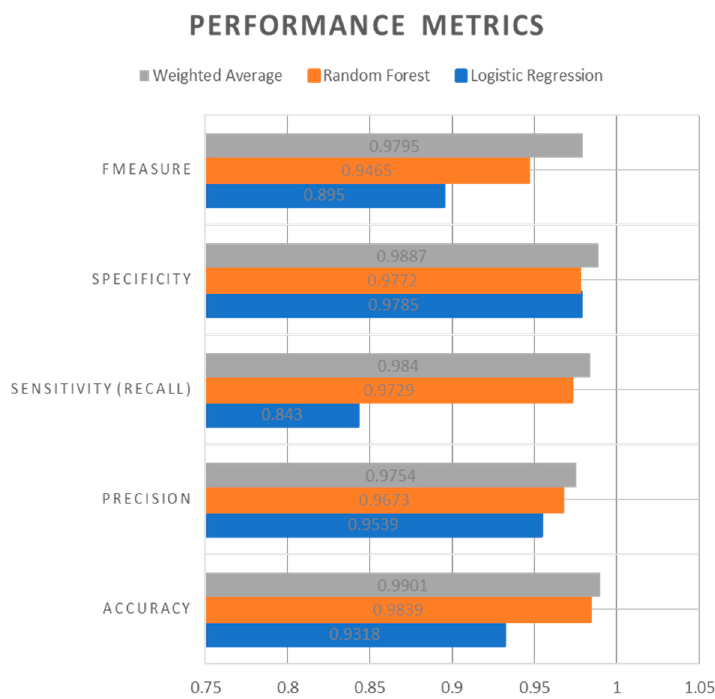
Figure 9. Performance comparison between Logistic Regression Model, Random Forest Approach, and the proposed Weighted Average Ensemble Model.